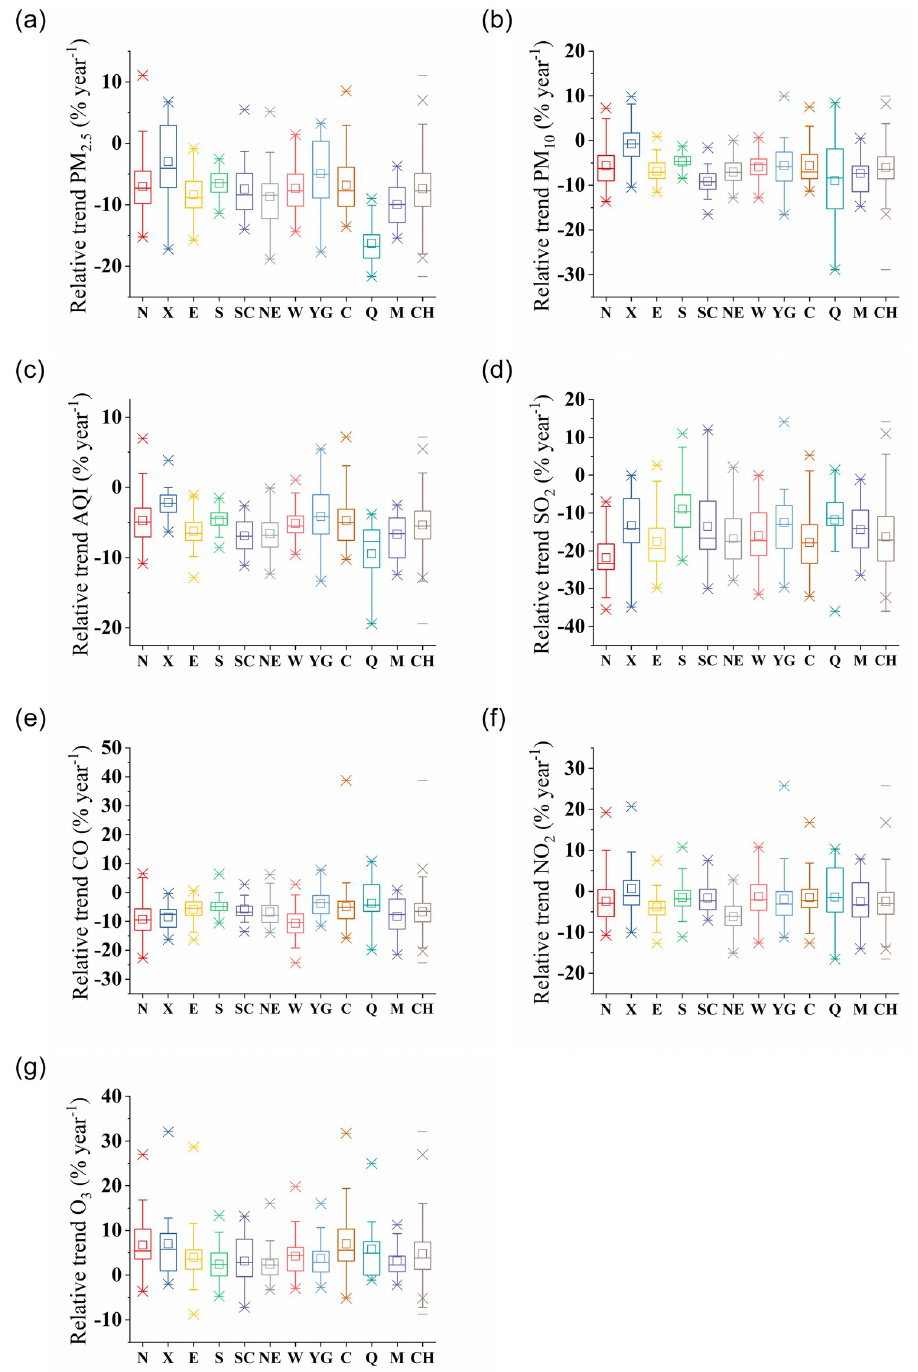
Fig 2. Annual average relative change from 2015 to 2019 in pollutants by region. The mean ( □ ), median (—), 1% ( × ). 99% ( × ), maximum (—), minimum (—), and interquartile range (IQR) of the trend in each region is shown.